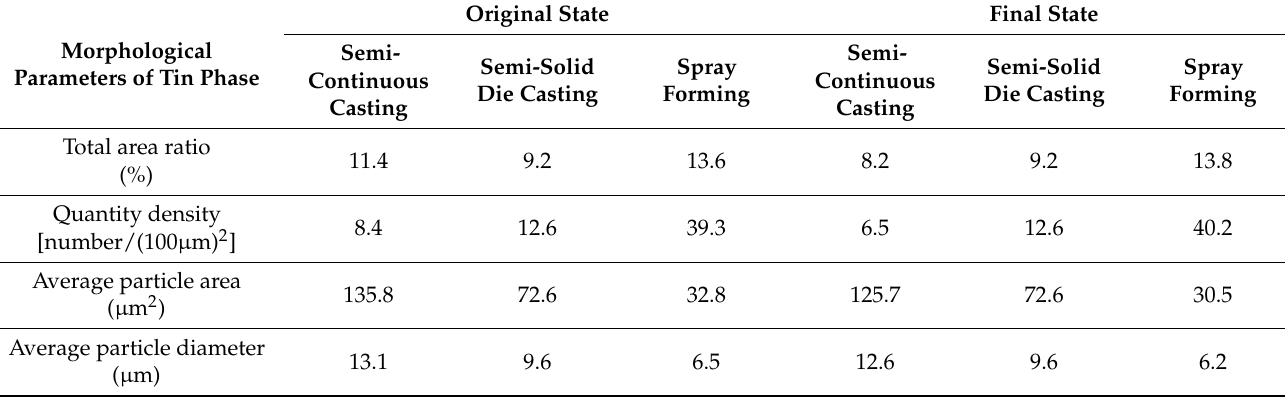
Table 1. Result of quantitative analysis of Sn phase